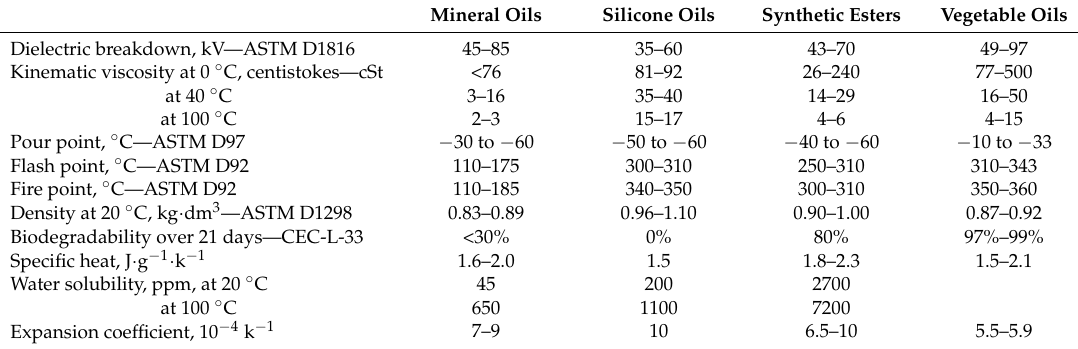
Table 1. Properties of typical transformer dielectric fluids (modified from Reference